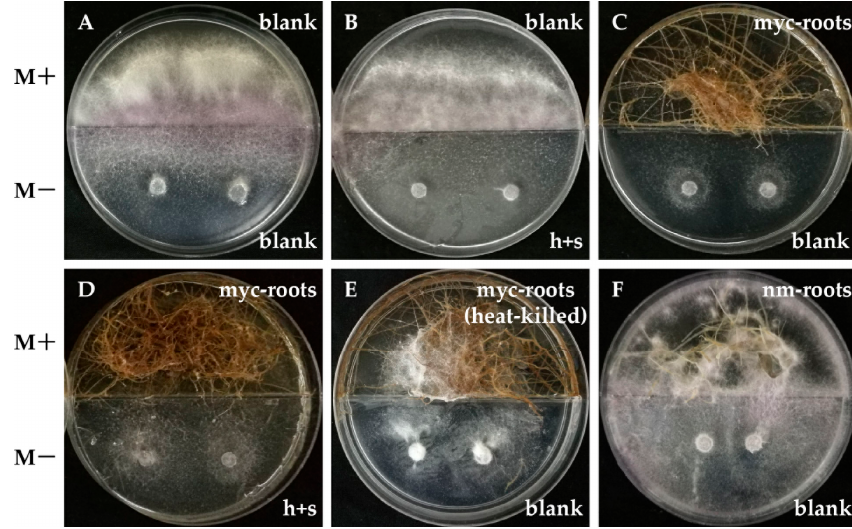
Figure 7. In vitro antimicrobial activities of AMF against Verticillium dahliae . Divided Petri dishes prevent nonvolatile solutes from diffusing between two compartments. The upper compartment of divided Petri dishes contained a complete growth medium (M+) used for the growth of AMF symbionts, and the lower compartment contained the same medium lacking sugar (M − ), thus permitting the development of AMF hyphae and spores. Two discs covered with V. dahliae of 5 mm diameter were transferred to the M − compartment and incubated in the dark at 25 ◦ C for 1 week. Before the inoculation of V. dahliae discs, fresh blank M+ and blank M − medium were decanted into divided Petri dishes. The height of M − was equal to the middle baffle while slightly higher than M+. The heights of M+ and M − in each plate were comparable to each other. Treatments were divided as follows: ( A ) empty M − and empty M+; ( B ) M − with AMF hyphae and spores (h + s) and empty M+;